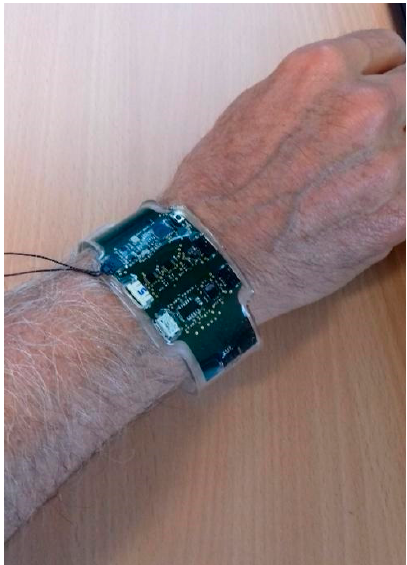
Figure 10. Low-power sensing platform integration in Sylgard ® 184 silicon .